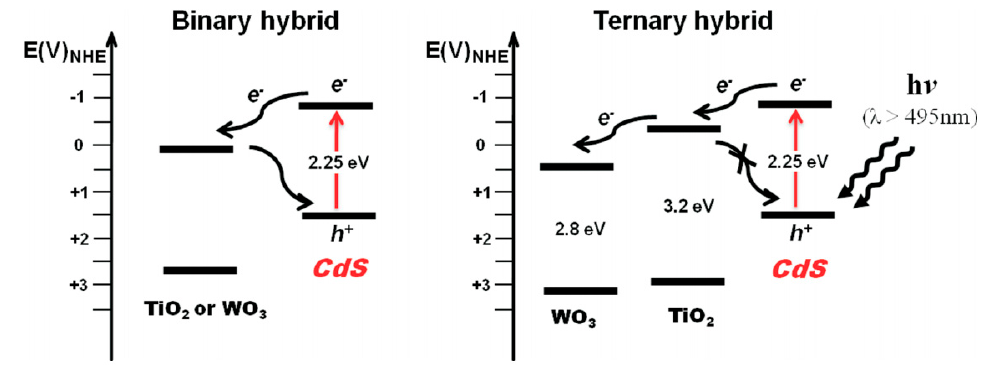
Figure 14. Schematic representation of a comparison of electronic transition processes in binary and ternary hybrid. Reproduced from [156], with permission from American Chemical Society, 2011.